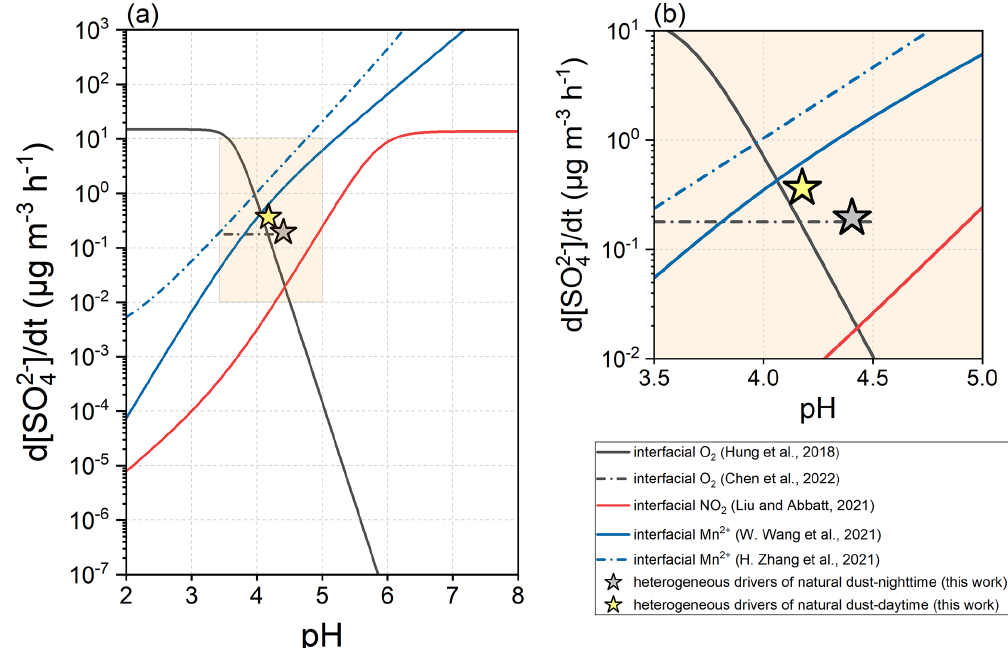
Figure 12. Kinetic comparison between microdroplet interfacial oxidation and the dust-driven heterogeneous pathway. The interfacial oxi- dation of SO 2 can be induced by the O 2 , NO 2 , or Mn 2 + at aerosol particle interfaces. The O 2 -dominated oxidation can be assessed by the method concluded by Hung et al. (2018). Chen et al. (2022) refreshed the assessment method relevant to interfacial O 2 , and the result here was obtained under the ionic strength of 40M within the pH range of 3.5–4.5. The NO 2 -dominated oxidation was assessed based on the work of Liu and Abbatt (2021). The Mn 2 + -dominated oxidation can be assessed by the methods of W. Wang et al. (2021) and H. Zhang et al. (2021). More parameterization and methodology details can be found in Text S5 of the